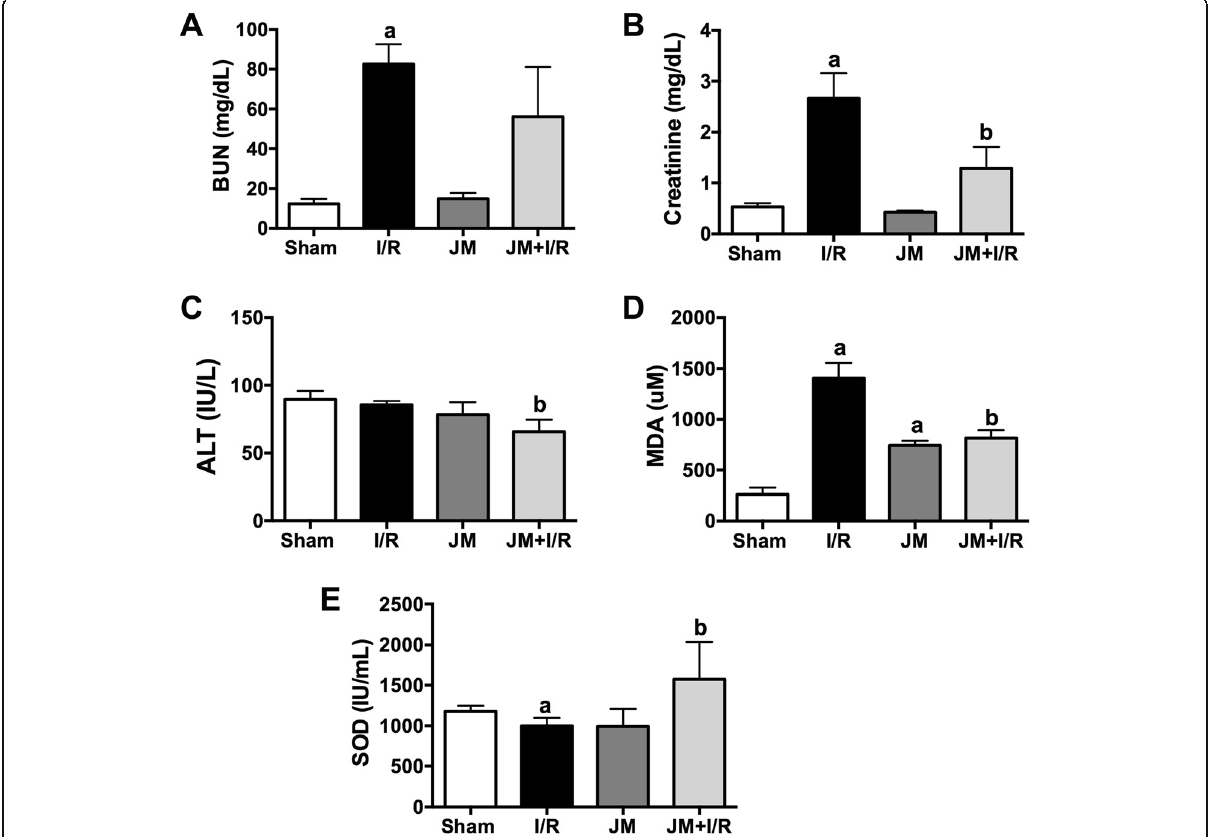
Fig. 1 Changes in ( a ) BUN ( b ) Creatinine, ( c ) ALT, ( d ) MDA, and ( e ) SOD levels after I/R injury. Values are mean ± SD. a. p < 0.05 comparison with the sham group; b. p < 0.05, comparison with IR